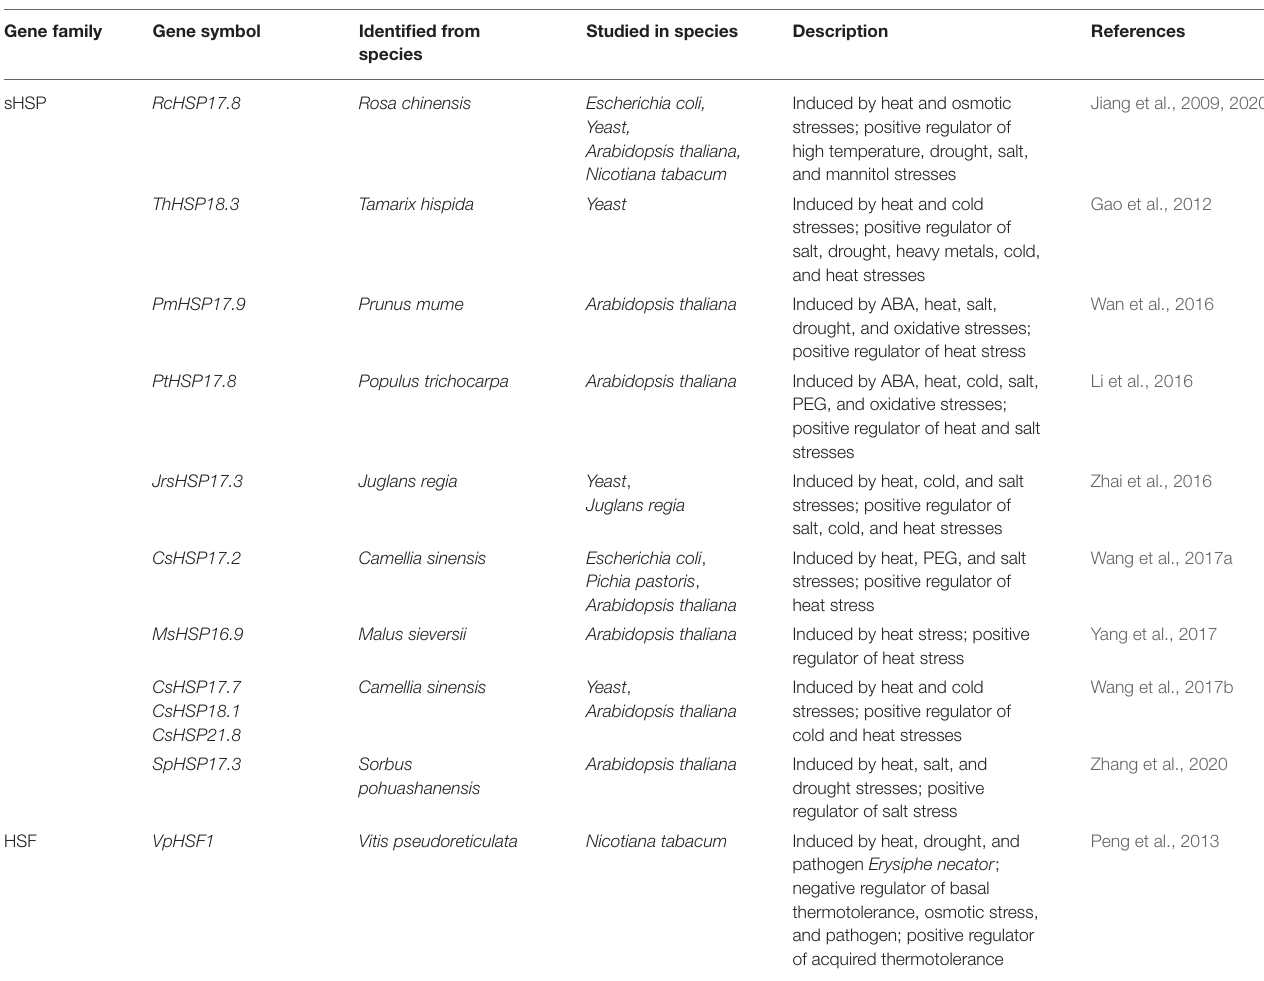
TABLE 1 | Summary of the HSP and HSF genes involved in heat stress in woody plants. Gene